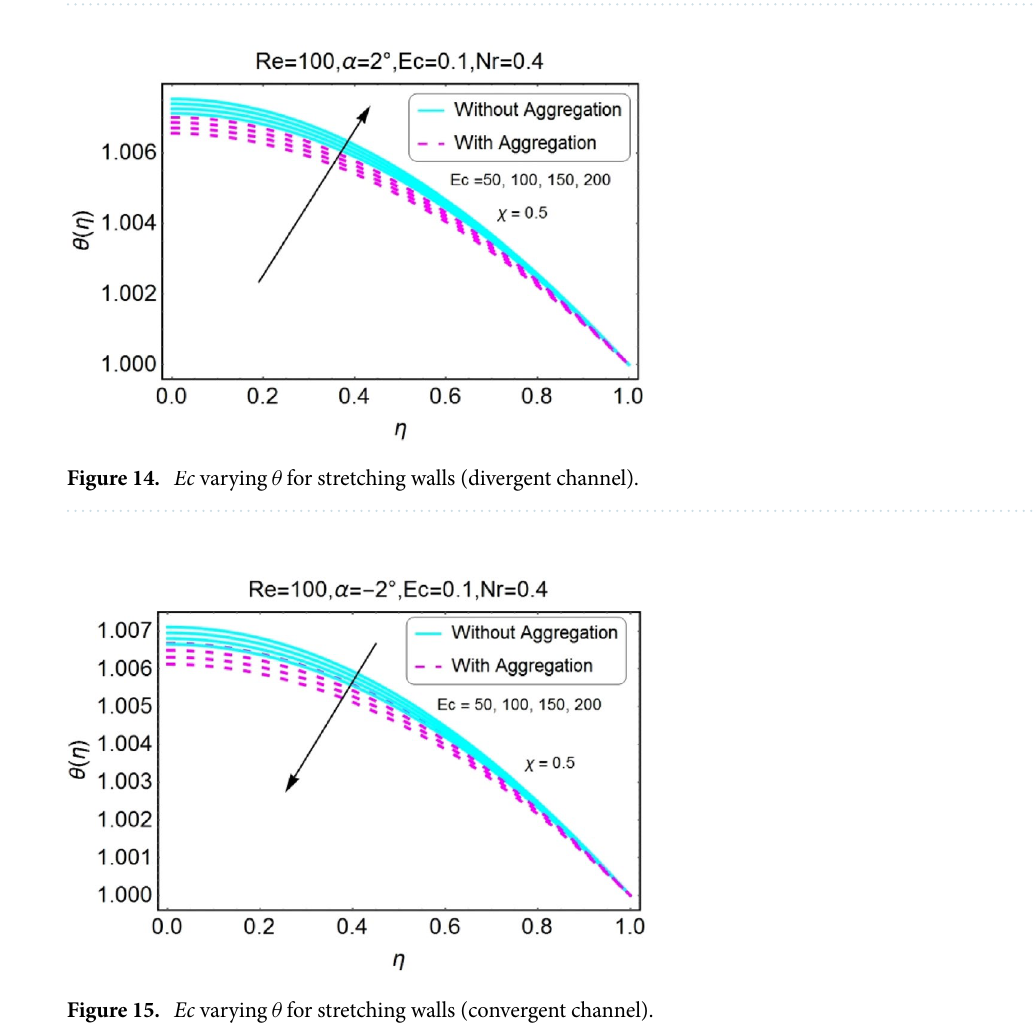
Figure 13. α varying θ for shrinking walls (convergent channel).